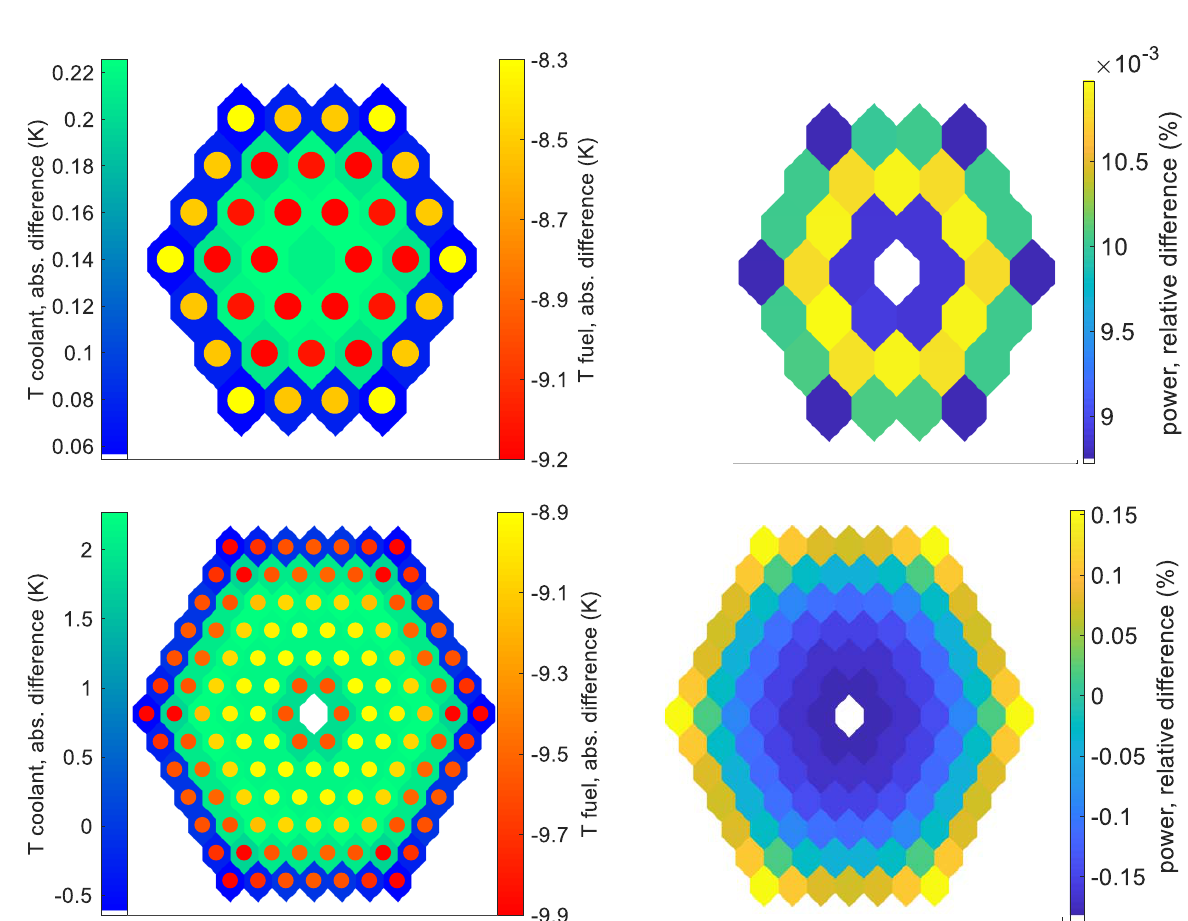
-p )/p ] and the nTF/CTF nTF/1D-TH nTF/CTF -T ] for a small and a VVER-440 nTF/CTF nTF/1D-TH